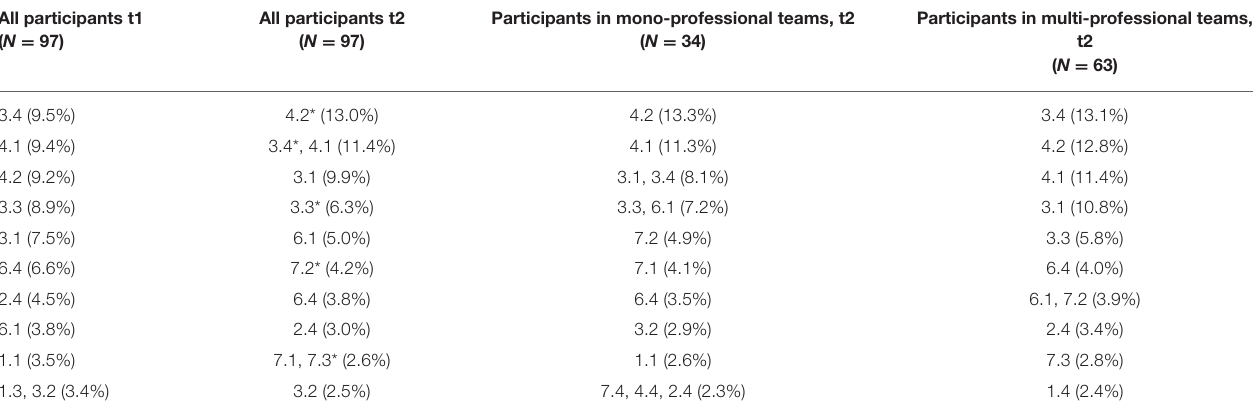
All participants t2 Participants in mono-professional teams, t2 ( N = 97) ( N = 34)